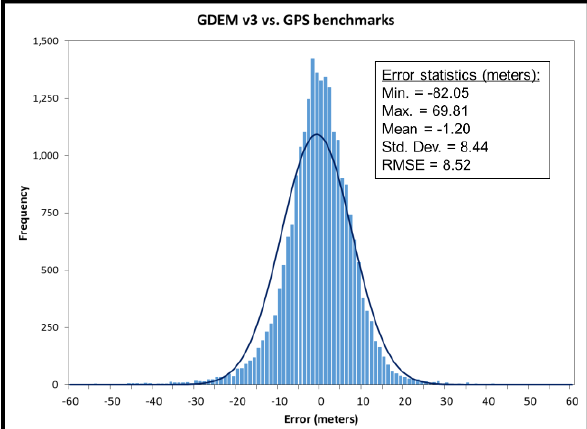
Figure 2. GDEM v3 measured errors plotted vs. elevation.